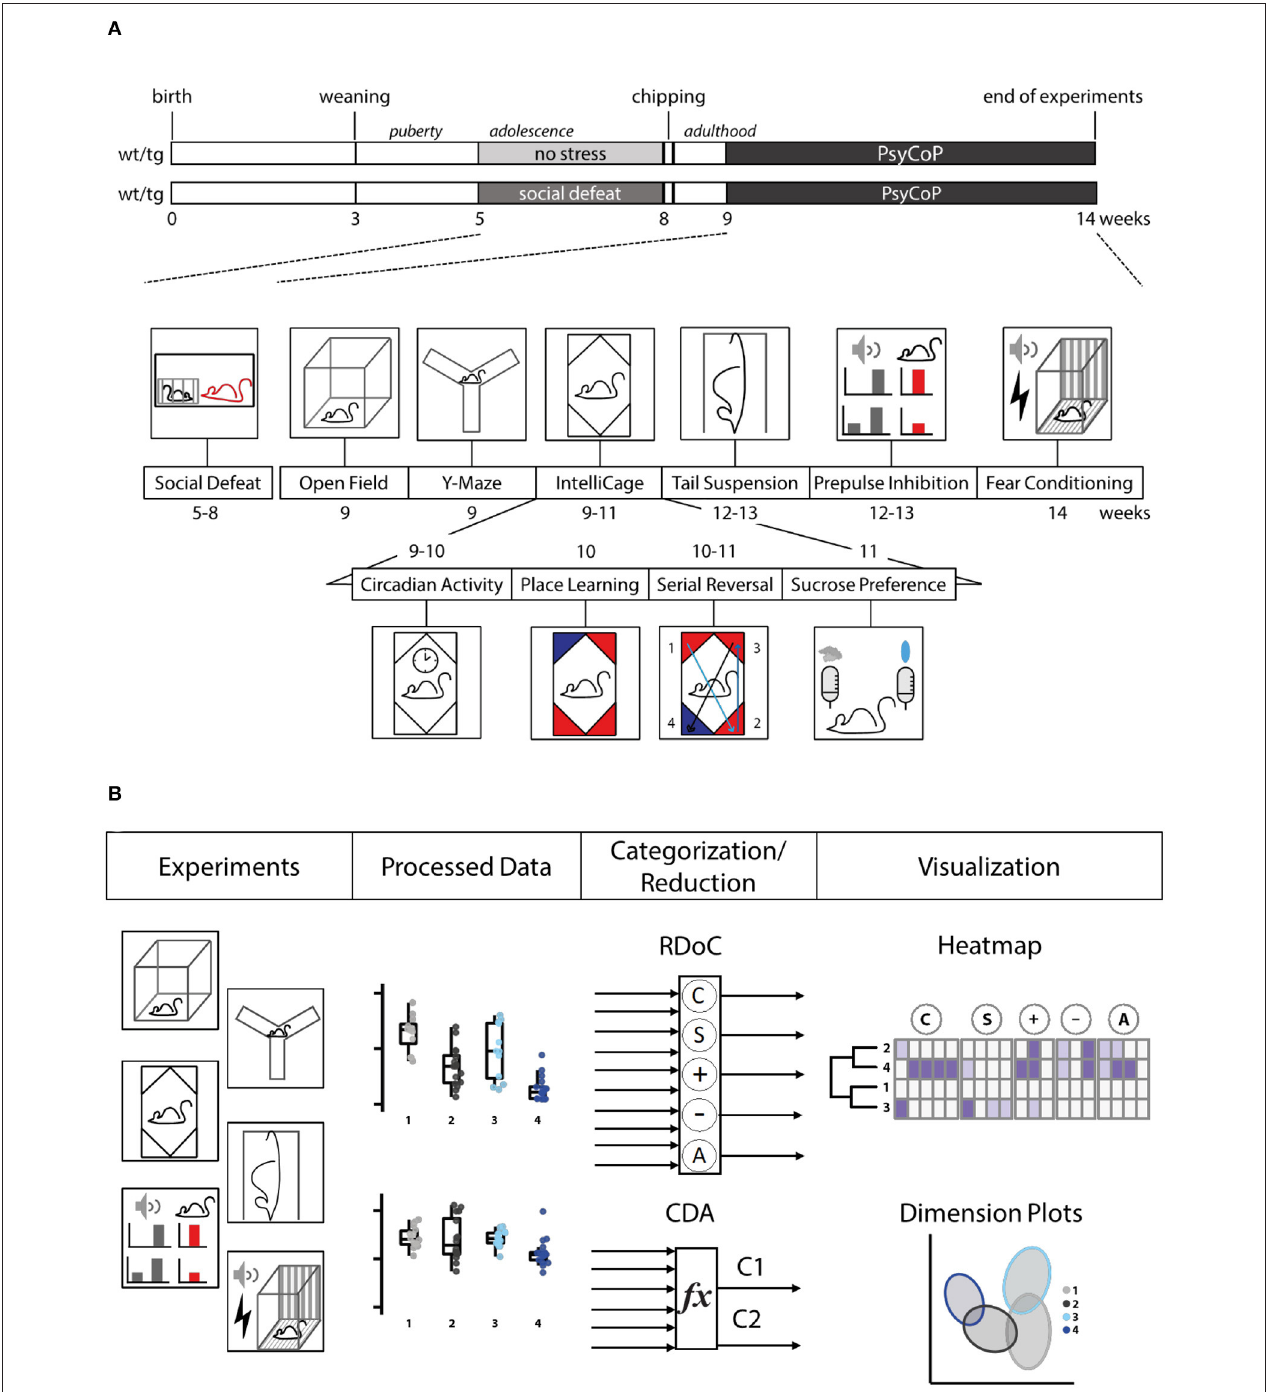
FIGURE 1 | Study design. (A) Timelines for Tcf4 tg (tg) and wildtype (wt) mice subjected to social stress during adolescence (social defeat; sd) or not (no stress control, ns). Behavioral testing took place during weeks 9–14, then RFID chips were implanted, and the animals subjected to behavioral tests in order of increasing aversiveness. (B) Schematic overview of the analysis pipeline. After semi-automated data processing, single variables were visualized and overall neurocognitive profiles were generated by categorization in accordance with the RDoC framework, resulting in a heatmap and dimension reduction via canonical discriminant analysis (CDA), resulting in a dimension